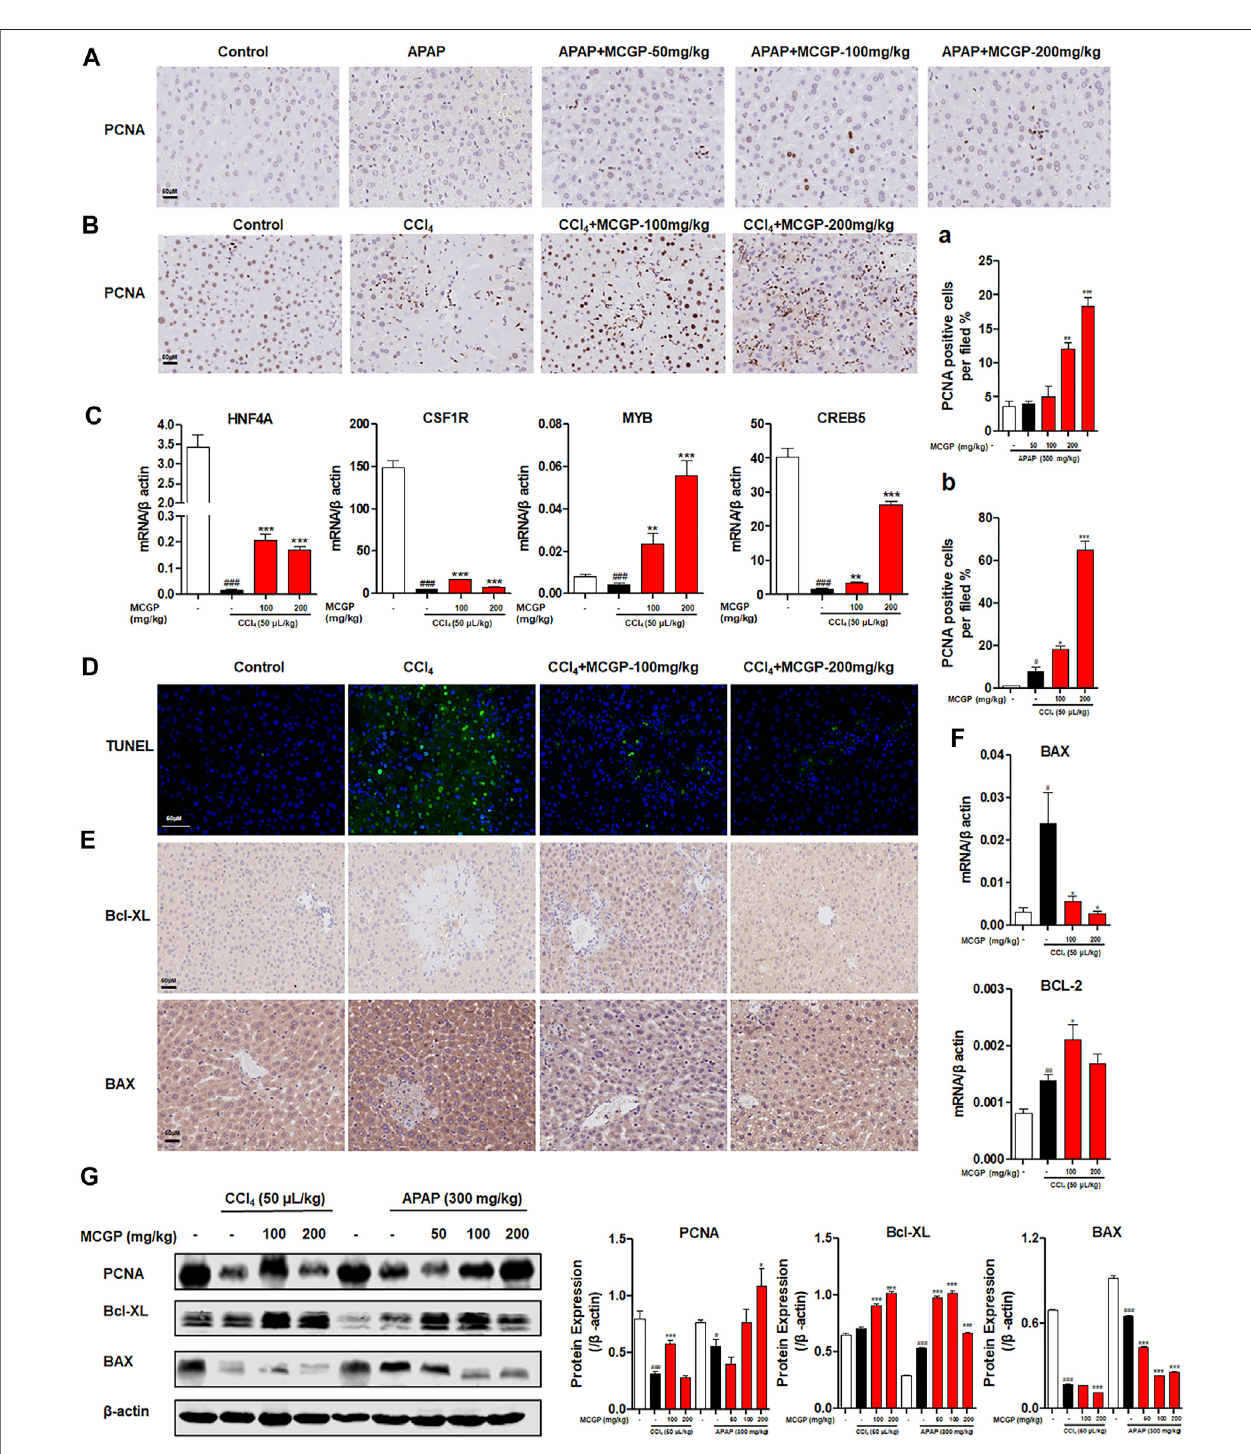
FIGURE 7 | MCGP promoted liver regeneration and protected against hepatocyte apoptosis in APAP-/CCl 4 -intoxicated mice. (A) Hepatic PCNA immunohistochemical staining of each group in APAP-intoxicated mice. (A) The number of PCNA-positive hepatocytes per fi eld. (B) Hepatic PCNA immunohistochemical staining of CCl 4 -intoxicated mice. (B) The number of PCNA-positive hepatocytes per fi eld, scale bar: 50 μ M. (C) Transcription level of HNF4A, CSF1R, MYB, and CREB5 ofeach group in CCl 4 -intoxicated mice. (D) TUNEL-staining of each group in CCl 4 -intoxicated mice, 200x. (E) Hepatic Bcl-XL and BAX immunohistochemical staining ofeach group in CCl 4 -intoxicated mice. (F) Transcription level of BAX and BCL-2 of each group in CCl 4 -intoxicated mice. (G) The protein expressionofPCNA,Bcl-XL,andBAXinlivertissuefromtheAPAPorCCl 4 groups.The β -actinwasusedasaninvariantcontrolforequalloading,followedbytheintegrity opticaldensityanalysesofeachblot.Datawerepresentedasthemean±SEM(n=3).# p < 0.05,## p < 0.01,### p < 0.001vscontrol,* p < 0.05,** p < 0.01,*** p < 0.001 vs